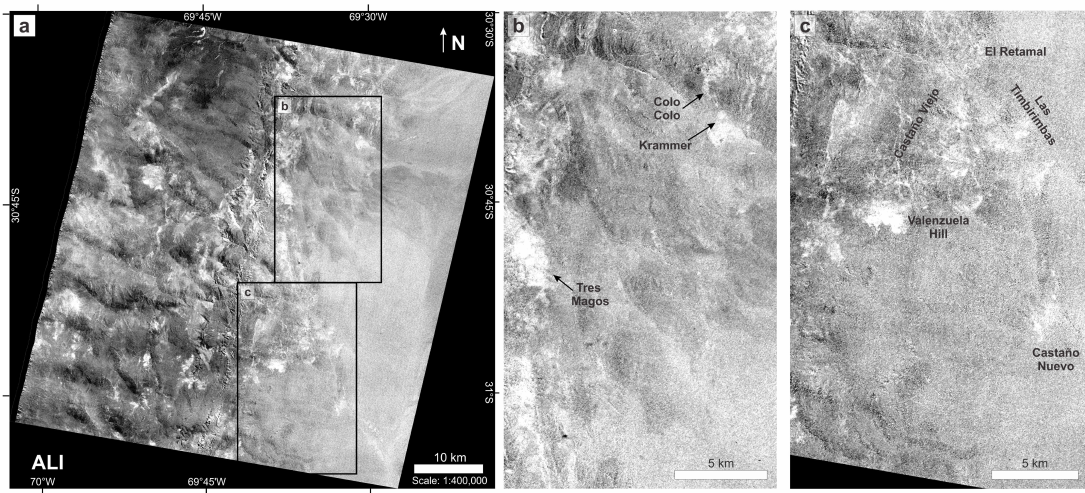
Figure 12. ( a ) Alunite index image (ALI), white zones represent areas where it is more likely to find alunite. The only hydrothermal alteration zones related to known ore deposits, which probably contain alunite based on dense clusters of white pixels are Tres Magos and Krammer to the north ( b ) and Valenzuela Hill to the south of the image ( c